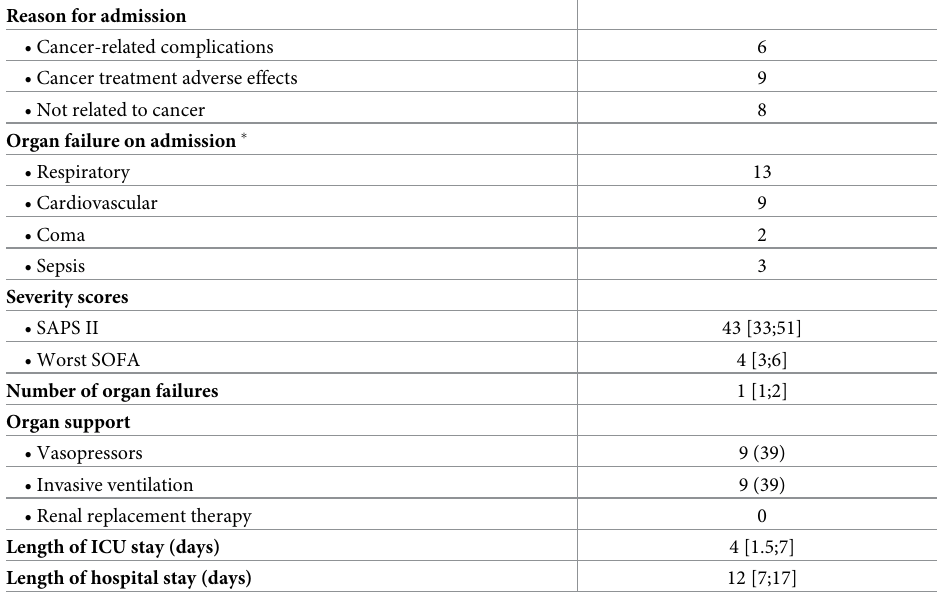
Table 2. ICU stay characteristics of the 23 ICU patients.